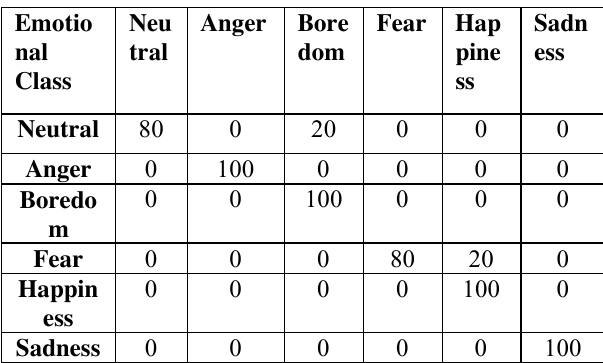
Table 2. Confusion Matrix for recognition using